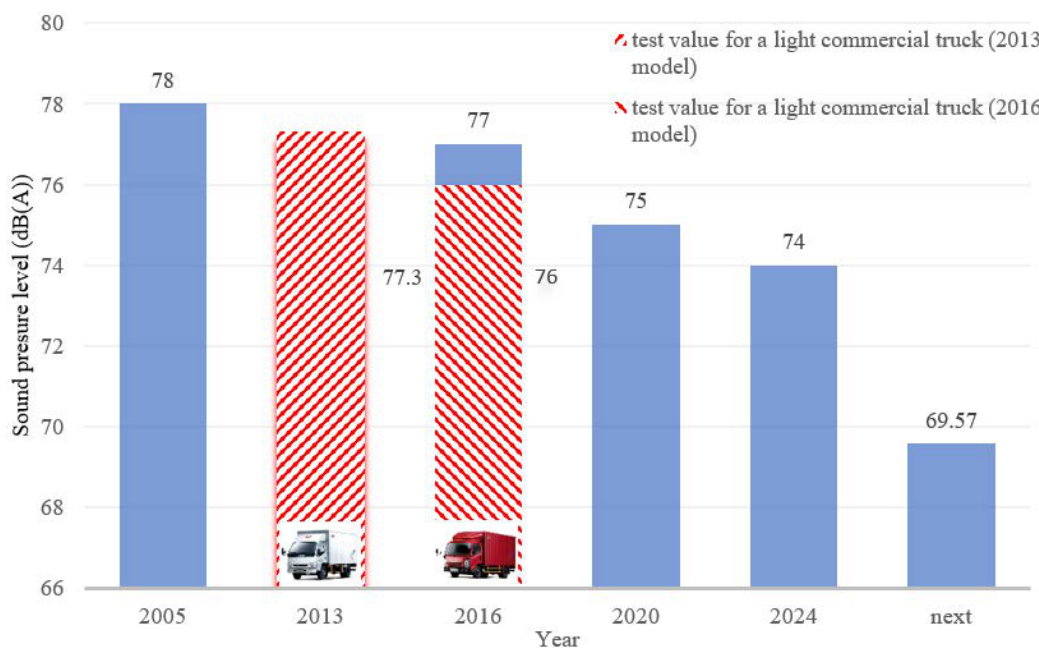
Figure 4. Comparisons on limits and test values for light commercial trucks (Category